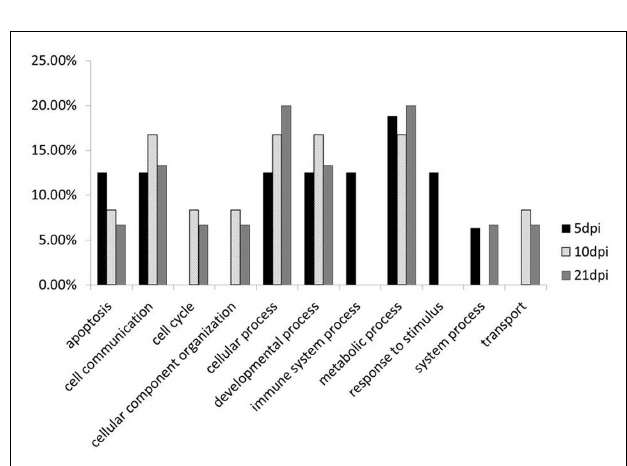
FIGURE 5 |Venn Diagrams of the number of genes have the methylation change at different time points and in different chicken lines. (A)The number of genes has the methylation change at 5, 10, and 21dpi. (B–D) The number of genes has the methylation change between L6 3 and L7 2 at 5, 10, and 21dpi respectively.